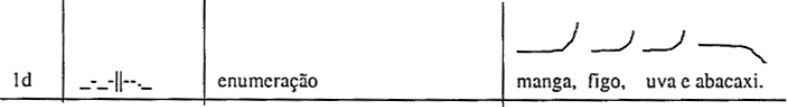
Figure 4. Enumerations. 'mango, fig, grape, and pineapple’. From Massini-Cagliari and Cagliari